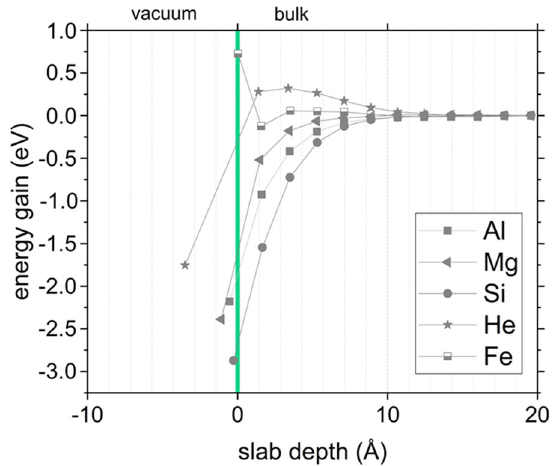
Fig. 6 DFT calculations revealing interaction of various impurities with (0001) beryllium surfaces. Energy gain due to substitutional impurities in a Be slab as a function of the distance from the slab surface for Al, Mg, Si, He and Fe. The substitutional helium is slightly repelled by the surface, but receives a signi fi cant energy gain by jumping into the bubble. Only the presence of iron at the surface is energetically unfavorable, while all other elements lead to a signi fi cant energy